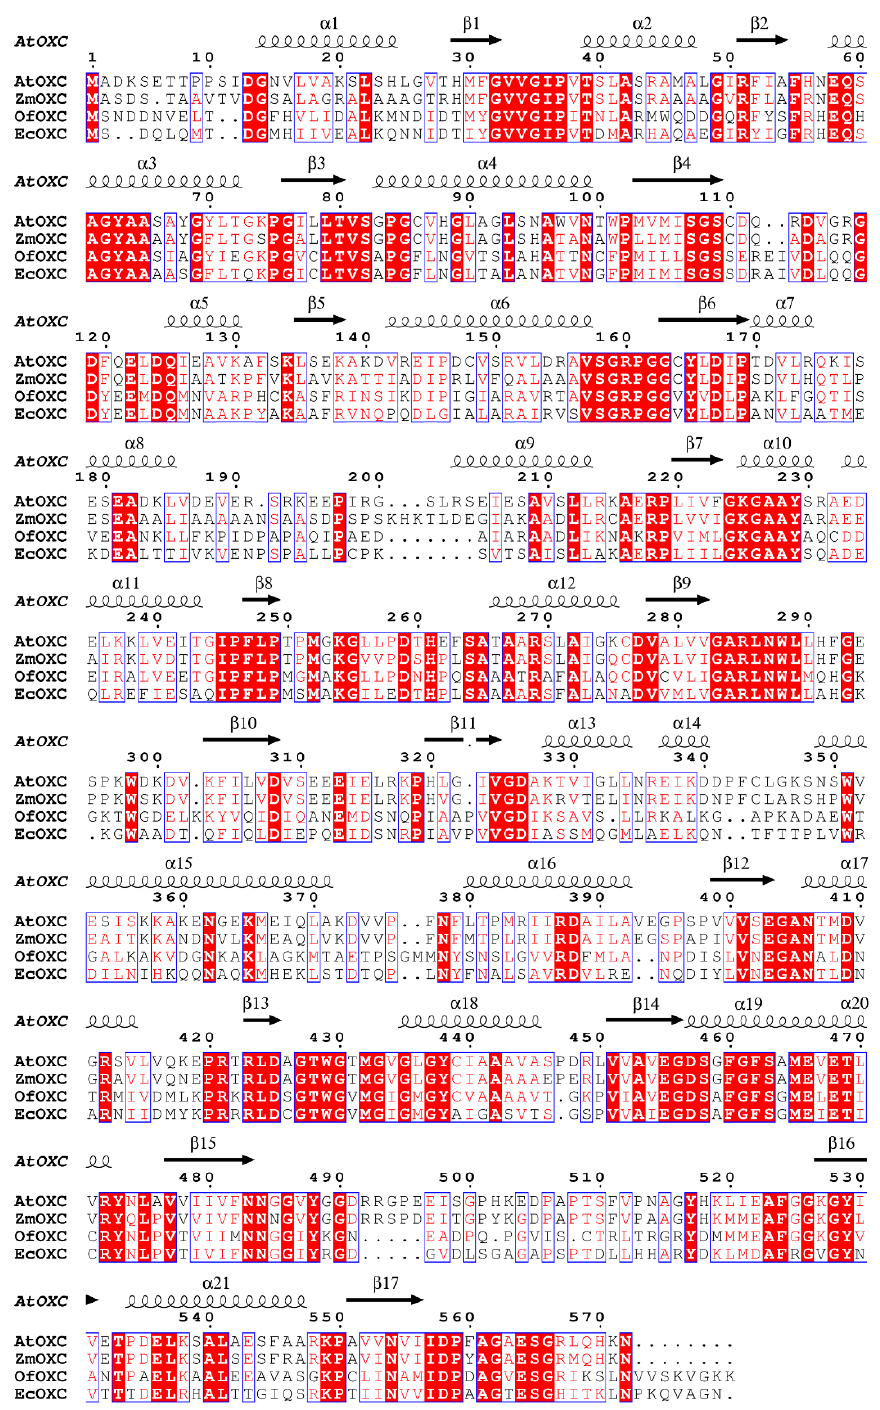
Figure 2. Comparison of the predicted amino acid sequences of OXC from plants and bacteria. Sequence alignment of OXCs from Arabidopsis thaliana , Zea mays , Oxalobacter formigenes , and E. coli . The secondary structure elements observed in the AtOXC modeled structure are shown above the alignment. Conserved residues are highlighted.